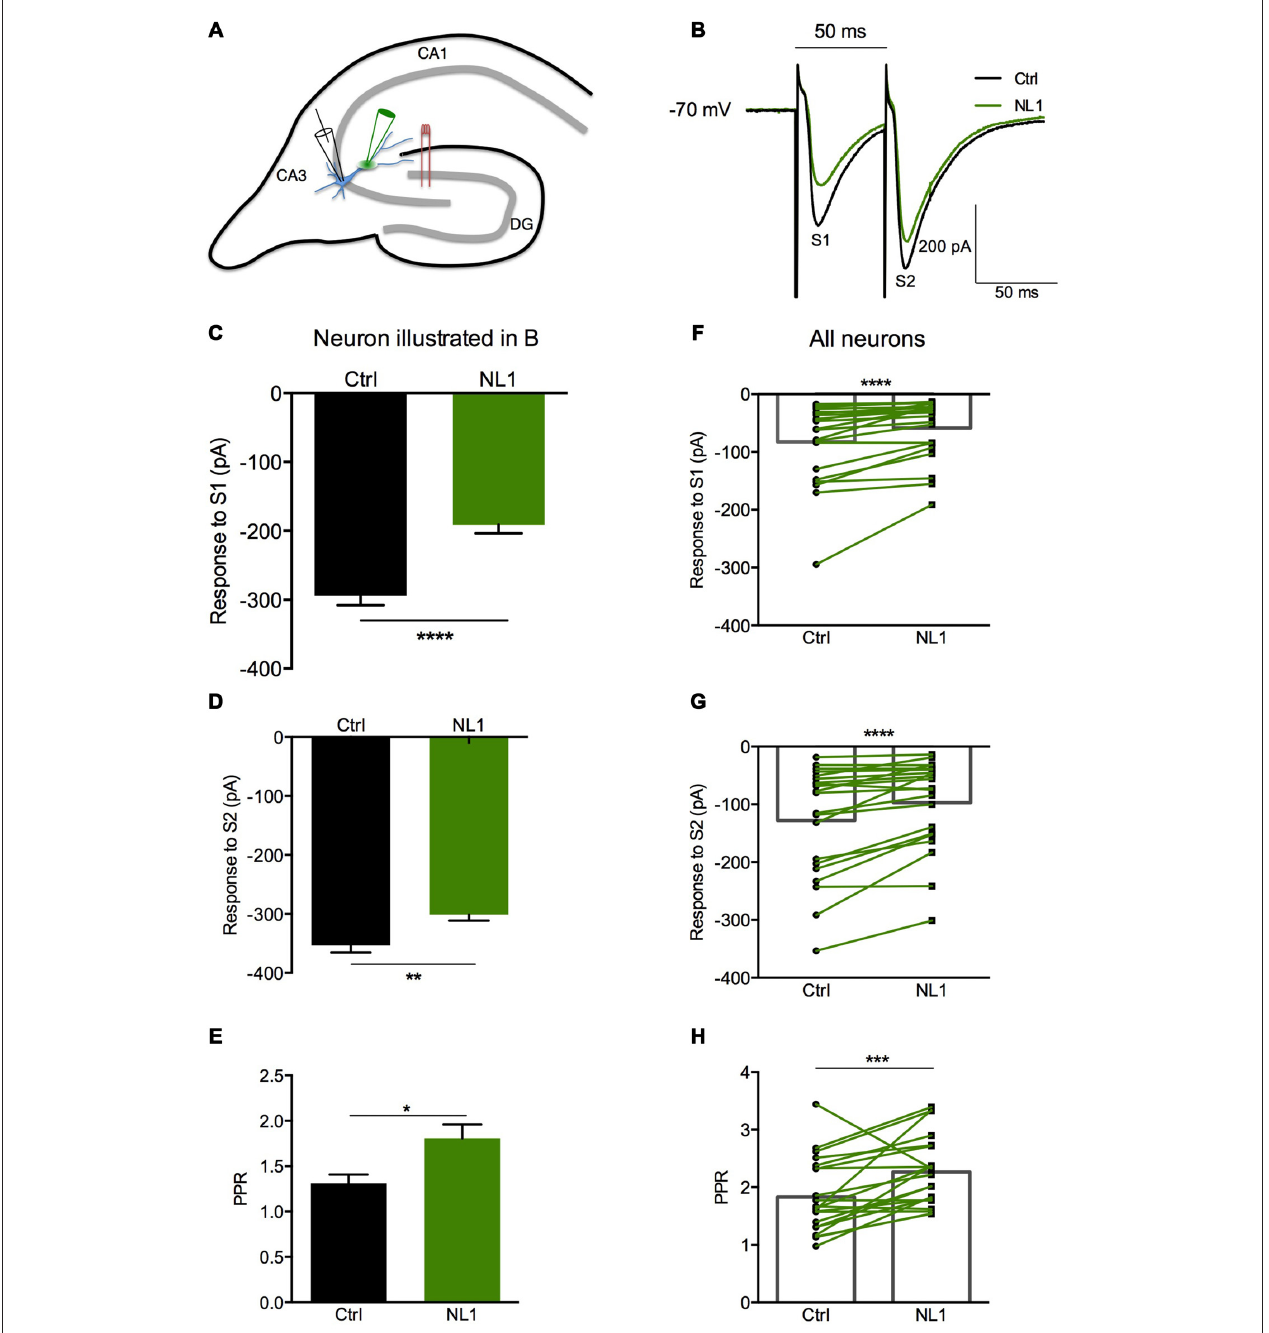
FIGURE 3 | The NL1 ectodomain produces presynaptic inhibition in CA3 neurons. (A) Schematic diagram of the preparation. Hippocampal CA3 neurons were recorded in voltage-clamp mode (Vh = − 70 mV) in whole-cell configuration. The synaptic stimulation of mossy fibers was produced by a bipolar electrode (red), patch electrode (black), and focal puff application of ecto-NL1 (green). N -methyl-D-aspartate (NMDA) receptors were blocked by AP5 (50 µ M). GABA receptors were blocked by SR 95531 hydrobromide (gabazine; 10 µ M). (B–E) Response of a CA3 neuron to two stimulations (S1 and S2) under control conditions (black) and after puffing ecto-NL1 near the apical dendrite of the recorded neuron (green). (C) The amplitude of the first EPSC decreased from − 294.6 ± 13.20 to − 191.1 ± 12.46 pA ( ∗∗∗∗ p < 0.0001, unpaired t -test; n = 30 sweeps). (D) The amplitude of the second EPSC also decreased but to a lesser extent (from − 353.4 ± 12.18 to − 301.1 ± 10.47 pA; ∗∗ p = 0.0019, unpaired t -test; n = 30 sweeps). (E) The PPR, which was calculated as the amplitude of the second EPSC divided by the first, significantly increased ( ∗ p = 0.0165, Kolmogorov Smirnov test; n = 30). (F–H) Results for all cells tested ( n = 21), with significant decreases for the first ( ∗∗∗∗ p < 0.0001) and second ( ∗∗∗∗ p < 0.0001) EPSCs (Wilcoxon matched-pairs signed-rank test). (H) Significant increase in the PPR for all cells together ( ∗∗∗ p = 0.0017, paired t -test; n = 21). In (F–H) bars show the mean values and lines correspond to individual pairs of values.